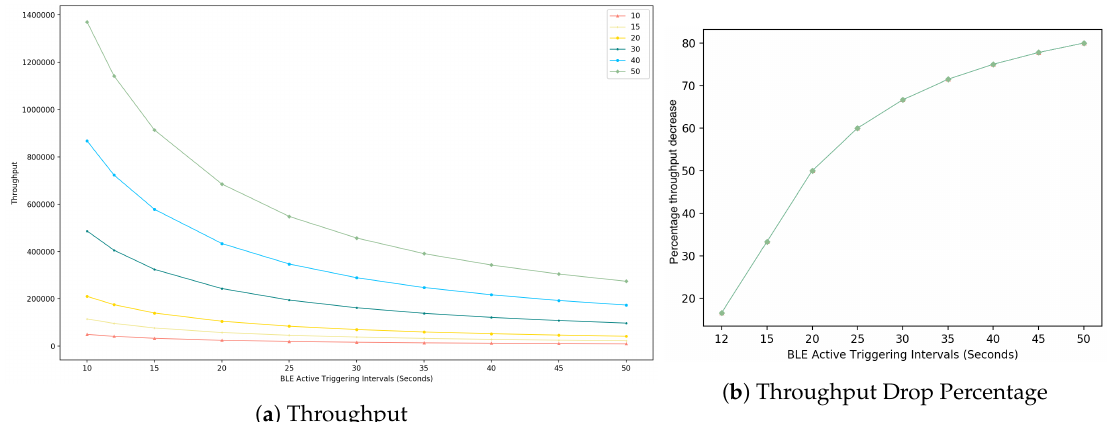
Figure 13. Throughput performance vs. BLE active triggering interval.